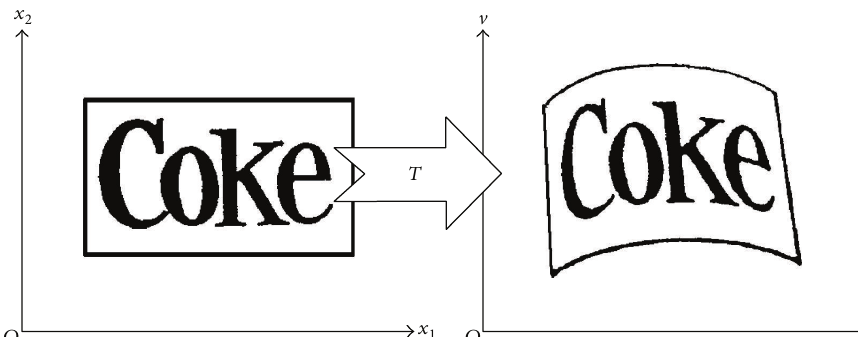
Figure 2: An image in Cartesian coordinates 𝑥 1 𝑂𝑥 2 is transformed into a new image in Cartesian coordinates 𝑢𝑂 V by geometric transformation 𝑇 .